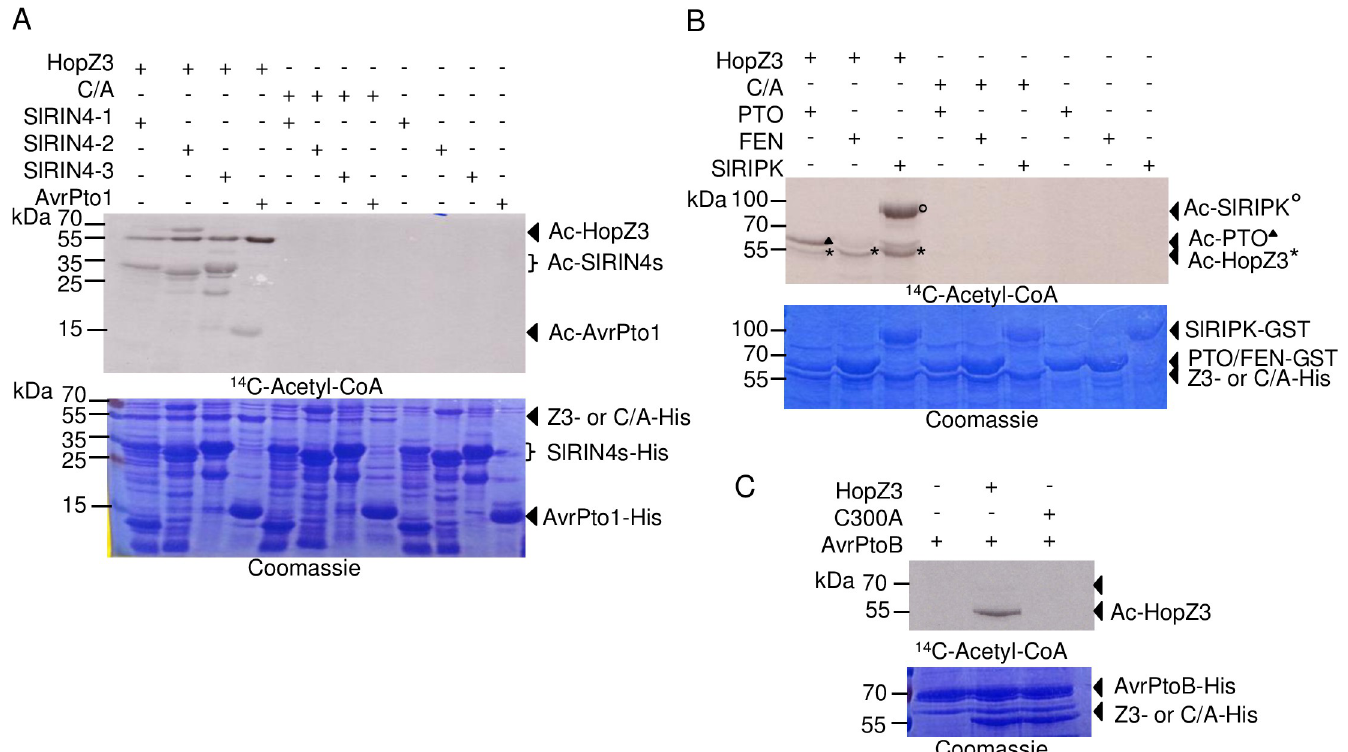
Fig 3. HopZ3 acetylates SlRIN4-1,-2, -3, AvrPto1 Psy , PTO, SlRIPK but not FEN or AvrPtoB Psy . Purified recombinant His-tagged SlRIN4-1, -2, -3, AvrPto1 Psy , AvrPtoB and GST-tagged PTO, FEN and SlRIPK proteins were incubated with His-tagged HopZ3 or HopZ3_C300A mutant (C/A) in the presence of IP6 and 14 C- Psy acetyl-CoA for 2 h at 30˚C. Samples were separated by SDS-PAGE and subjected to autoradiography for 14 days. (A) SlRIN4-1, -2, -3 and AvrPto1 Psy were acetylated by HopZ3. (B) PTO and SlRIPK were acetylated by HopZ3; however, FEN acetylation was not detected. (C) AvrPtoB